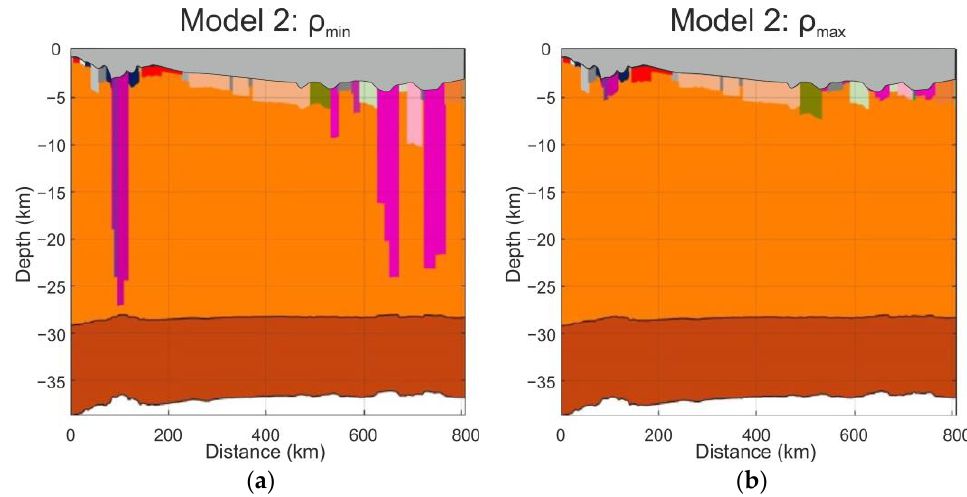
Figure 7. Reconstructed present-day upper part of the basement design for Model 2: ρ min ( a ) and Model 2: ρ max ( b ). The grey area is the basin part. The colour codes beneath the basin part correspond to those of the basement units presented in Table 1. The layer of the lithospheric mantle is not displayed for the convenience of presenting the picture.